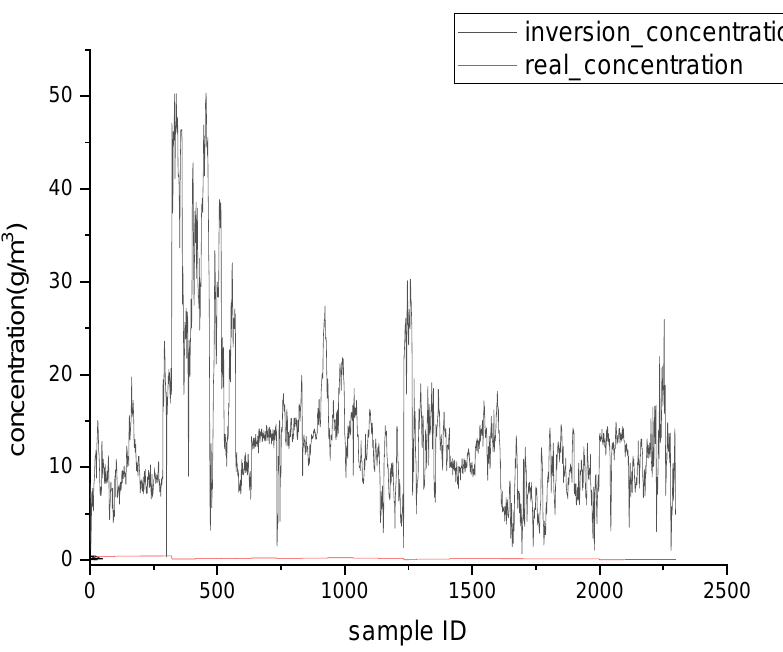
Figure 9. Single-wavelength inversion results at 330 nm.